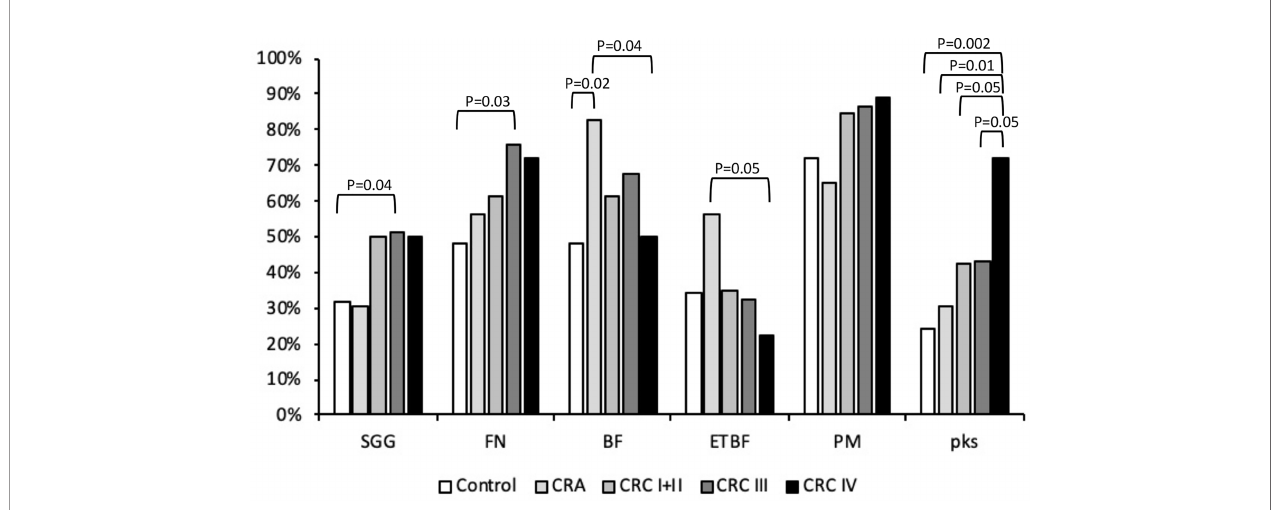
FIGURE 1 | Presence of Streptococcus gallolyticus ( SGG ), Fusobacterium nucleatum (FN), enterotoxigenic Bacteroides fragilis (ETBF), and Parvimonas micra (PM) pks gene in feces. The presence of bacterial DNA was tested by PCR using speci fi c primers ( Table 1 ). Statistical signi fi cance was calculated using the c 2 test or Fisher ’ s exact test (when n < 5). The real p -value is indicated for groups displaying signi fi cant differences.